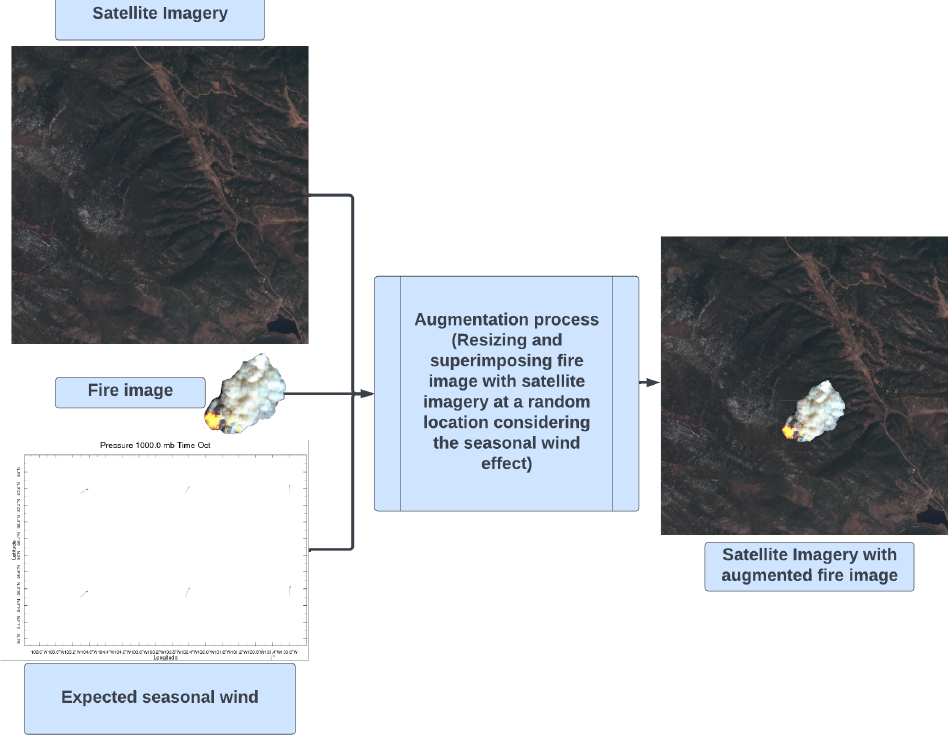
Figure 2. Augmentation of fire image in satellite